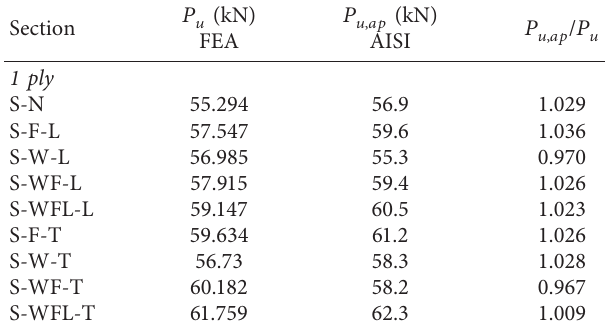
Table 11: Long column ultimate load estimates, for 1, 2